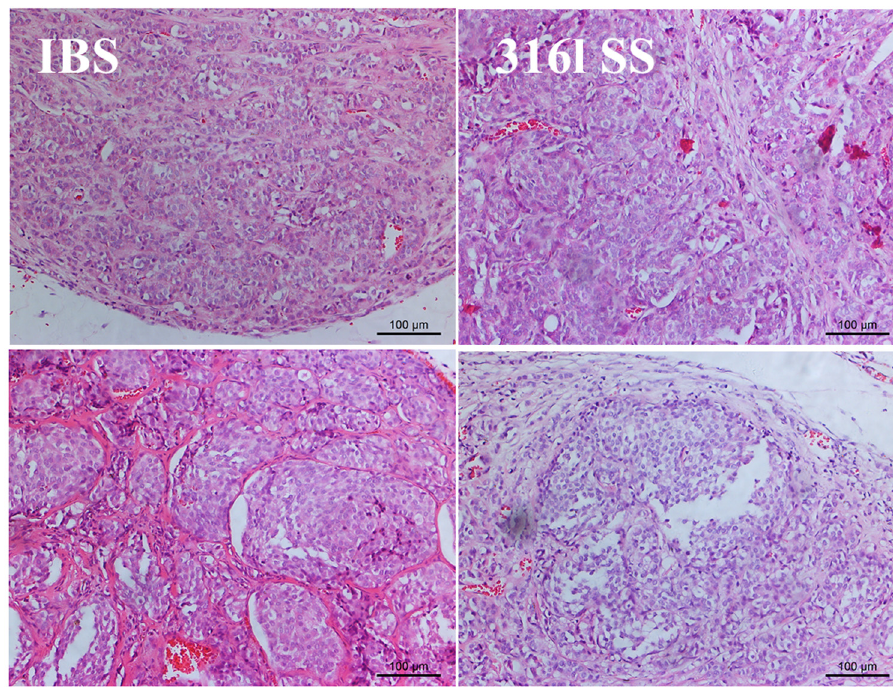
Figure 6: Pathological images of tumor in the IBS group and 316L SS group ( scar bar is 100 µm )